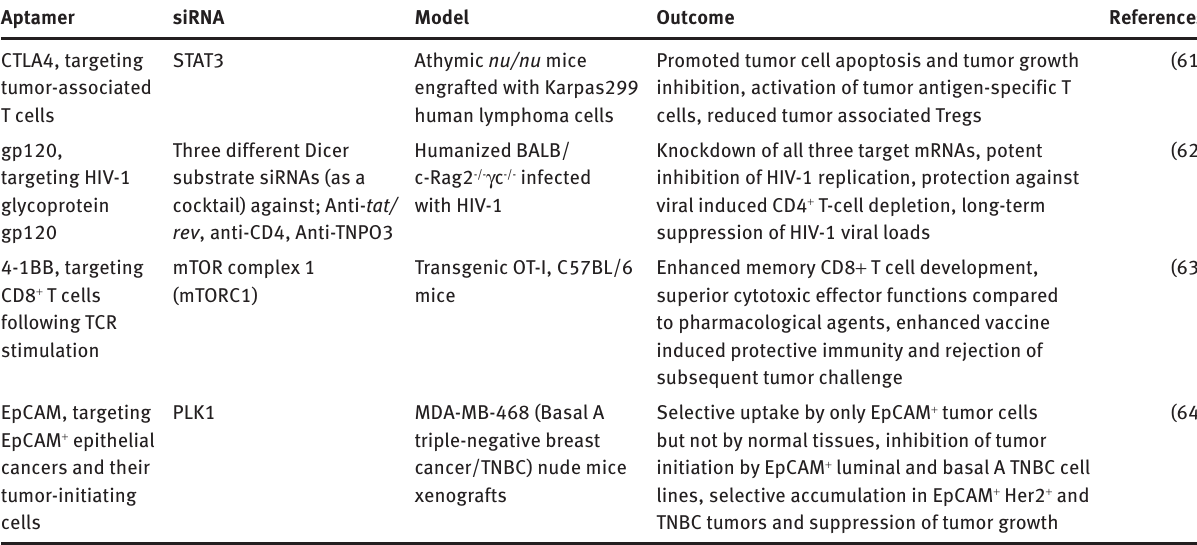
Table 1: Recent aptamer-siRNA conjugate systems (chimeras) for successful in vivo siRNA delivery.